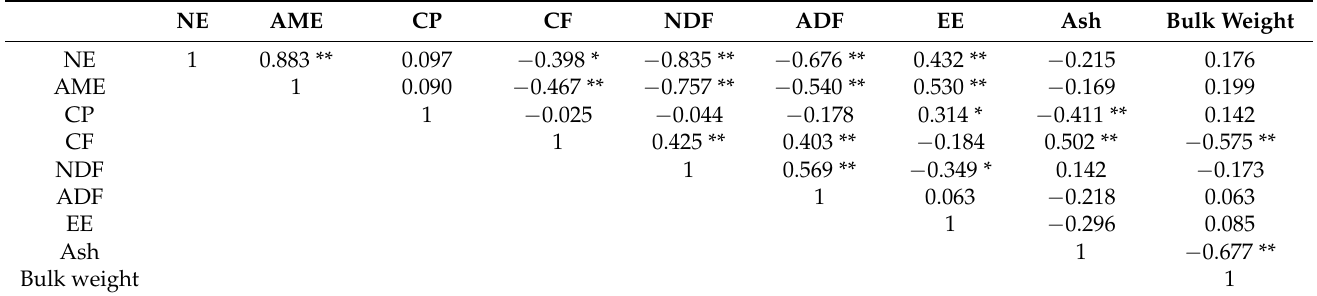
Table 5. Pearson correlation coefficient between NE and AME, conventional composition of wheat